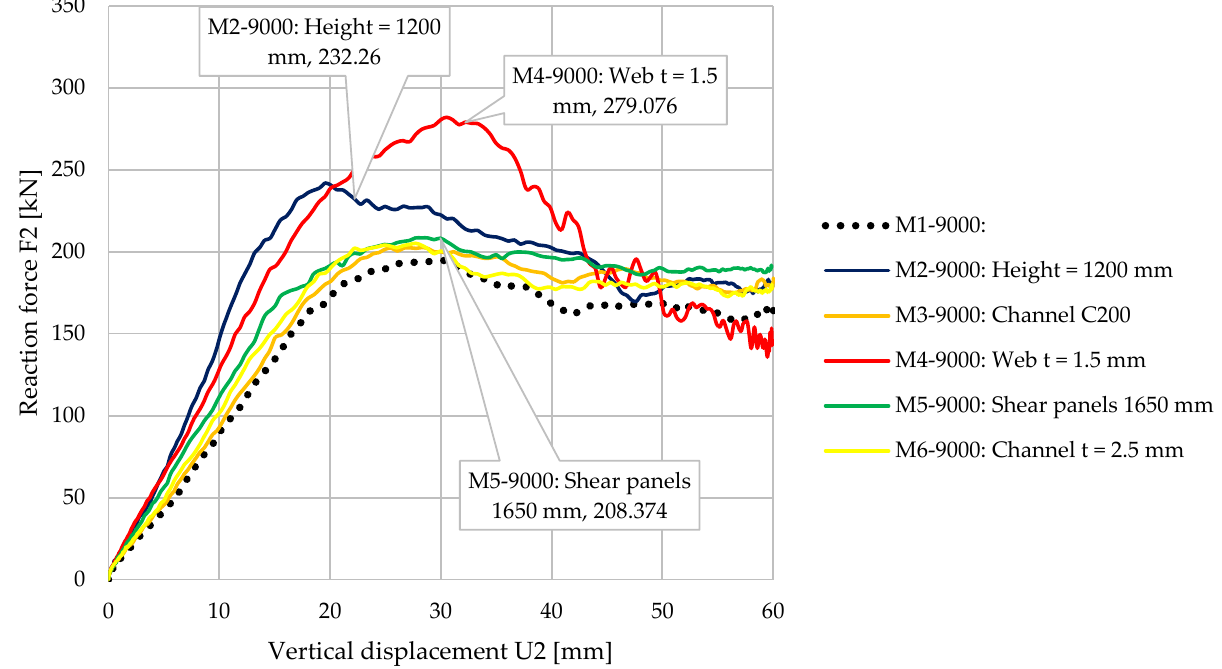
Figure 22. Parametric study for the beam without a web opening and a length of 9000 mm.